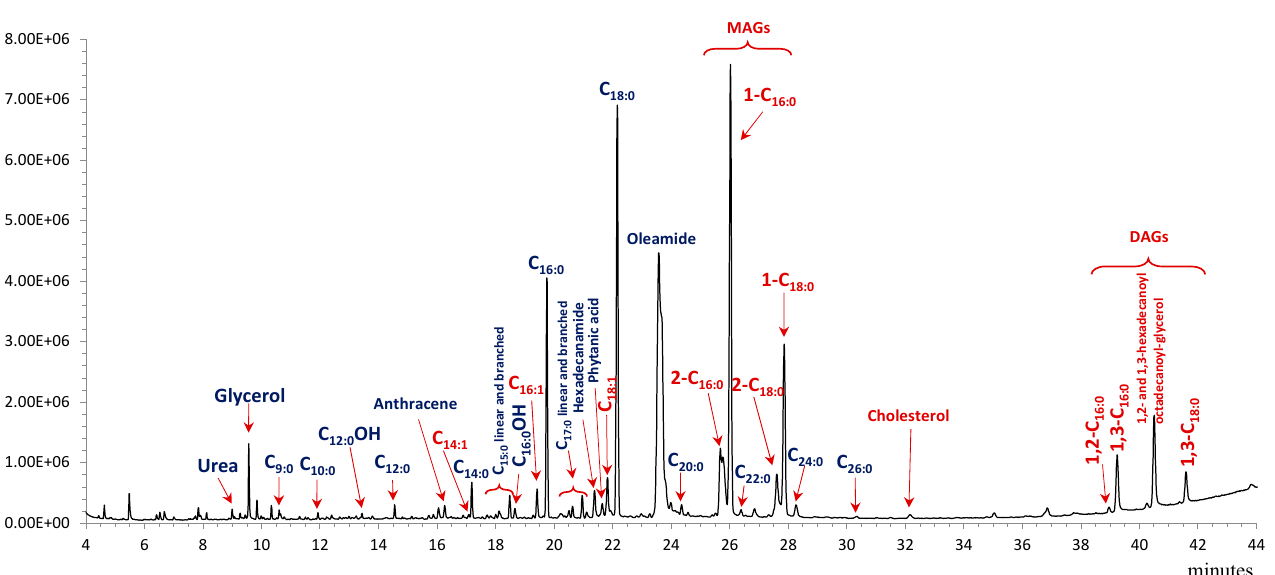
Figure 7. Gas chromatogram obtained from the total lipids extract. Cn:x, fatty acids with carbon length n and number of unsaturation x.